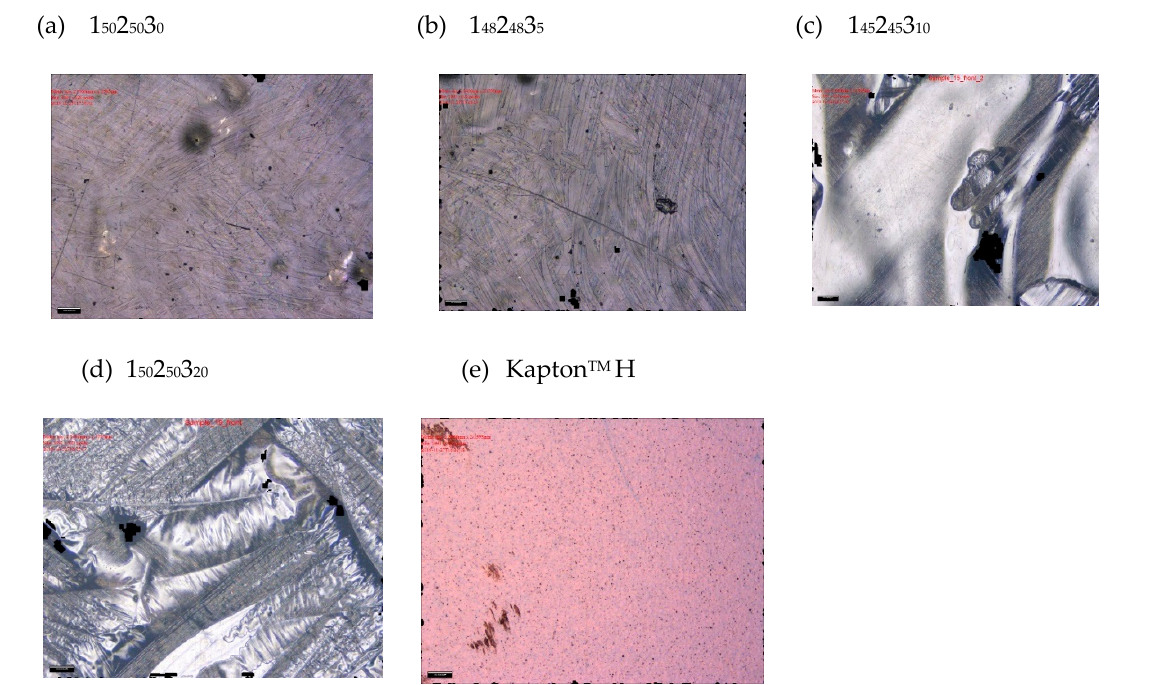
Figure 4. Microscopies of top (exposed) surfaces of all cured samples and Kapton TM H before exposure (N.B. scale bar represents 200 μ m).